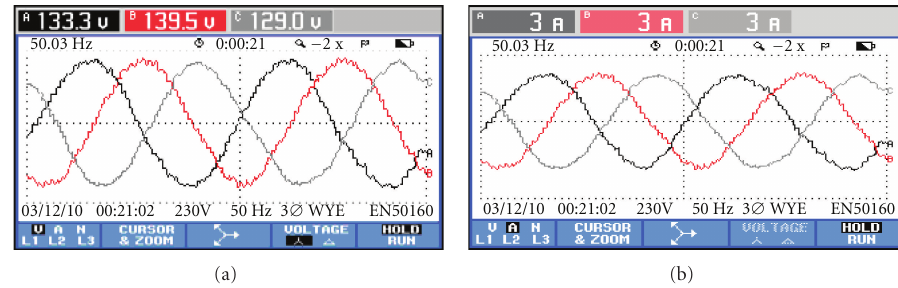
Figure 14: Inverter three-phase output waveform (a) voltages and (b) currents.